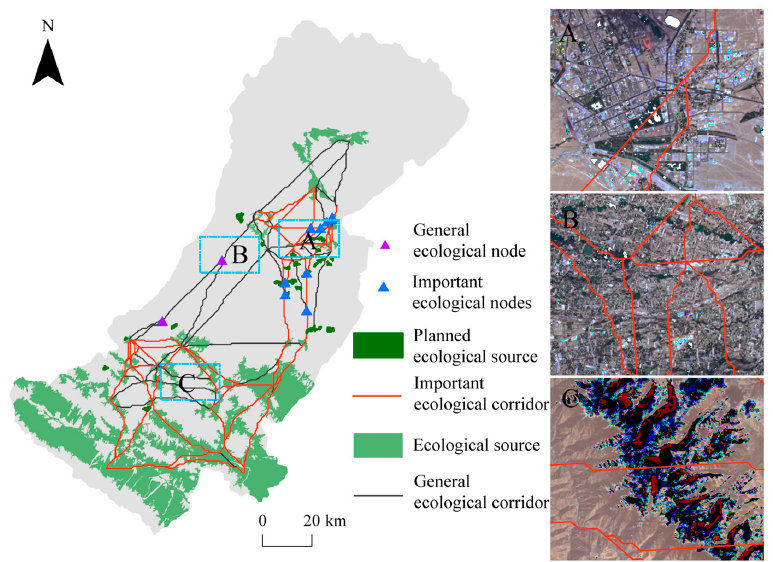
Figure 12. Planning of EN in Taolai River Basin. Note: A. B and C are enlarged images overlaid with special ecological corridor vector and remote sensing image: A. ecological corridors passing through the urban built-up areas, B, ecological corridors on both sides of the river, and C. ecological corridors that passes through a large area of glaciers and snow areas.